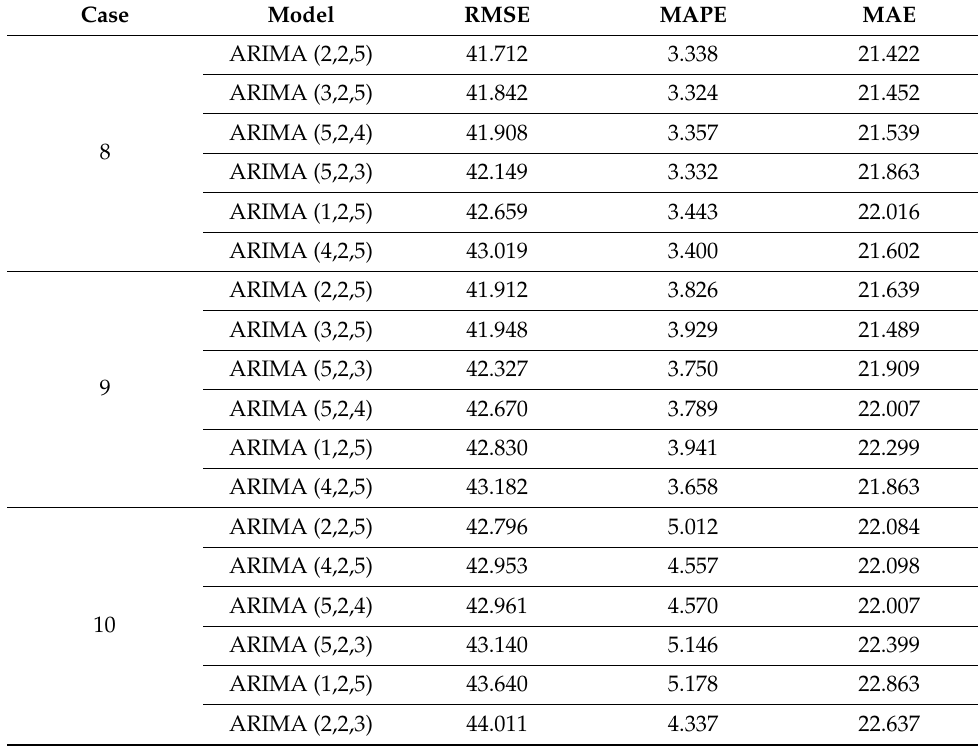
Table 5. Results of ARIMA models for Group 3 (case